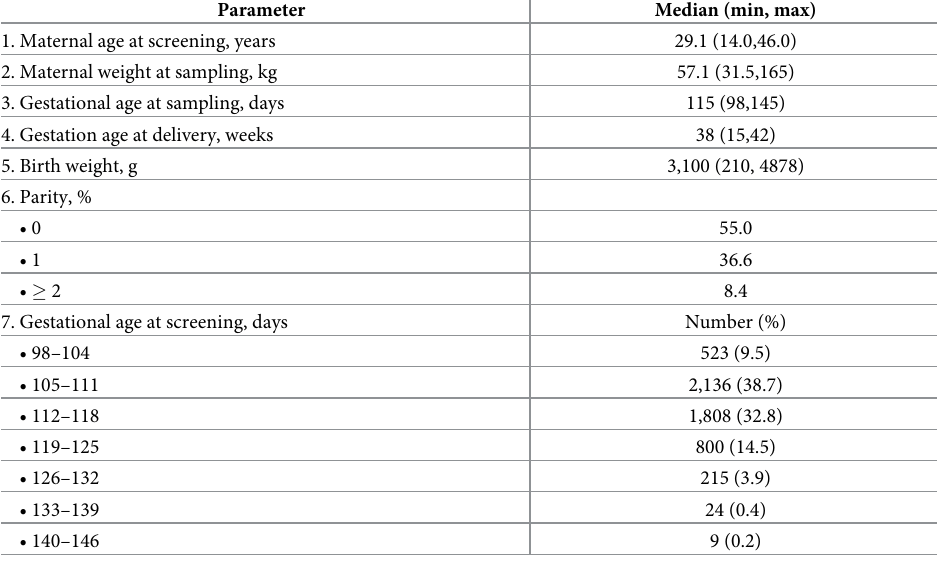
Table 1. Demographic data of the pregnant women who underwent quadruple maternal serum screening (5,515